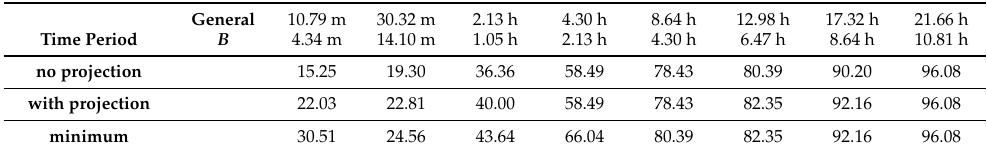
Table 6. Rejection rates along different length periods when no projections are used (first row), when the proposed projection procedure is used (second row) and when no multiplicity is taken into account (third row), i.e., the minimum of the p -values is used for the rejection. m stands for minutes and h for hours.